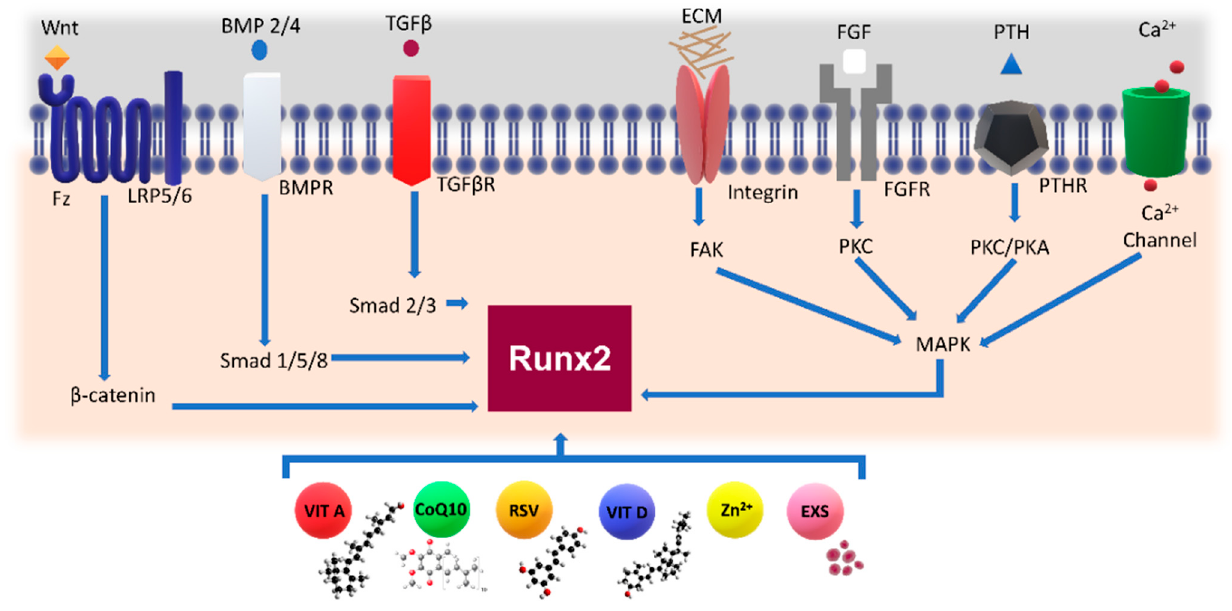
Figure 4. The regulation of Runx2 by mechanical and soluble ossification agents. Mechanical signals perceived by membrane-bound receptors such as lipoprotein-related protein (LRP) 5/6 and the frizzled (Fz) co-receptors, TGF β and/or BMP receptors, integrins, FGF and G proteins (as an example, the PTH receptor is indicated) and stretch-activated Ca 2+ channels regulate Rnux2 activity. Major regulatory pathways are represented. Biochemical agents such as vitamin A, coenzyme Q10, resveratrol (RSV), vitamin D, zinc ion and exosomes (EXS) can affect Runx2 and thus osteoblast